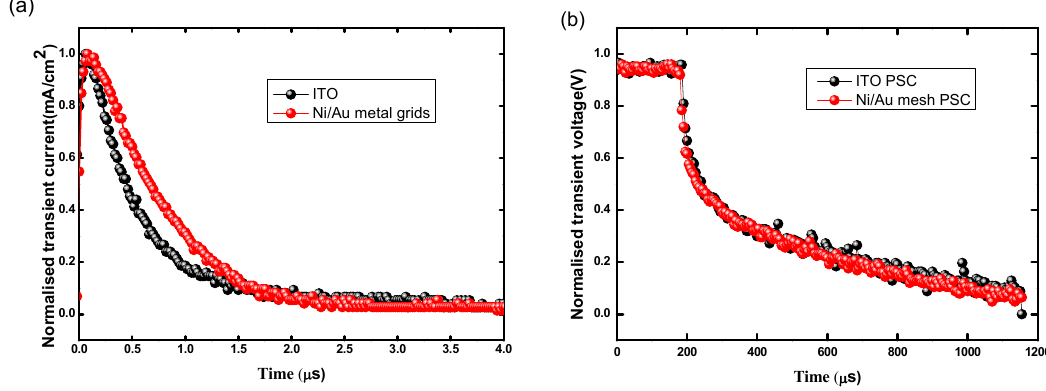
Figure 5. ( a ) Transient photocurrent (TPC) and ( b ) transient photovoltage (TPV) decay curves of the PSCs based on Ni/Au mesh and ITO electrodes.